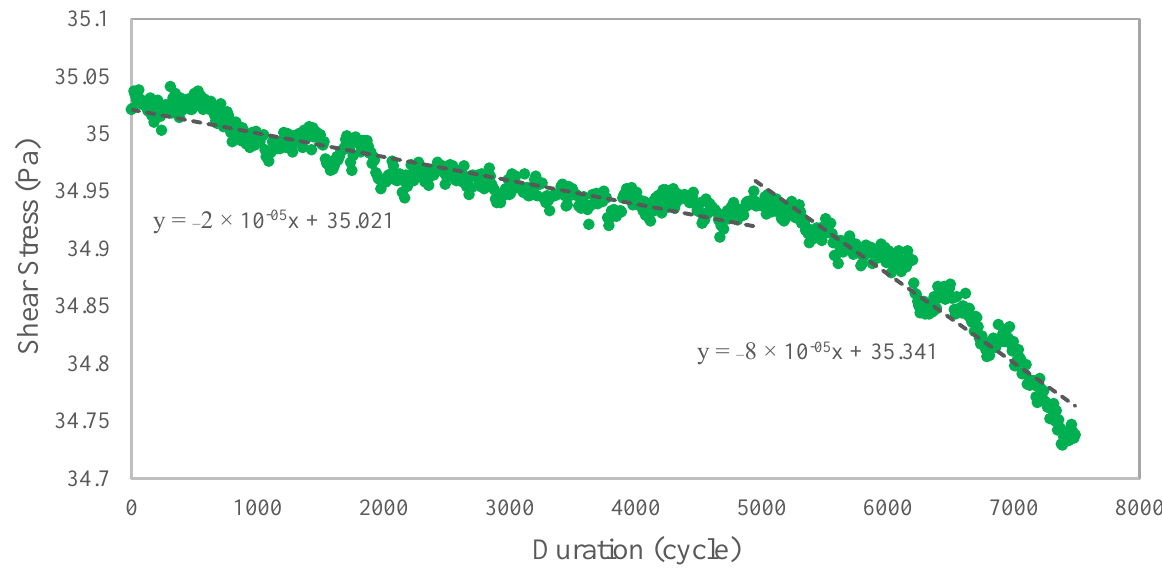
Figure 7. Shear stress performance over the test duration. The sample that reacted to minor changes in its original condition was studied at this early stage. Based on this finding, it can be concluded that a slow degradation process occurred in this material during the initiation of the resilience condition, and the degrada- tion changed as the test duration increased. Specifically, the molecular chain structure of this material is capable of sustaining the elastic performance, and improved sustainability can be achieved through the response to magnetic stimulation, which effectively alters the elastic performance. MRE conceptualization consists of a molecular chain structure and the cross-linkages of cured MRE, as shown in Figure 8. The secondary interaction in this study was the restricted region between the amorphous matrix and the CIP crystalline molecular chain structure. The CIPs with rigid spheres in the crystalline molecular structure were randomly embedded in the matrix, resulting in them molecularly embracing a portion of the enclosed matrix, which is known as secondary interaction. MRE’s elasticity and deformation limits are determined by the cross-linkages formed during the curing process. Such cross-linkages are a critical structural factor, as they impart high elastic properties while also stiffening the MRE system to prevent a viscous dominant response [4]. As a result of the constant shear stress by the MRE, the stress was distributed over the molecular structure, disentangling the chains and causing molecular slippage. As more slippages and cross-link losses occur in the MRE, the molecular structure becomes insufficient to be reconfigured, resulting in permanent deformation, as illustrated in Figure 8. As shown, prior to the durability test, the matrix’s amorphous molecular structures were un-stretched with the initial cross-linkage position (red color) generated after the curing process. The CIPs were embedded in the matrix amorphous molecular structure with rigid spheres in the crystalline molecular structure at random. During shear, the velocity gradient that developed across the sample was greater at the most outer section and decreased toward the center. The shear band development and its mechanism significantly impacted the shear profile generated across the sample in this study. The illustrated figure depicts the mechanism of shear deformation in the sample’s center following durability testing. The stretched region was just below the localized elastic limits among the entangled amorphous molecular chains during the initial stress relaxation process, and the cross- linkages were then reversibly aligned. At this point, no permanent deformation occurred during the stretching. As a result, no visible marks could be seen. However, the constant shear load repeatedly softened the chains, eventually pushing them over the localized elastic limit. As a result, the plastic flow occurred in the inner portion of the molecular chain, just beyond the localized limit. The fluctuating stress that developed in the